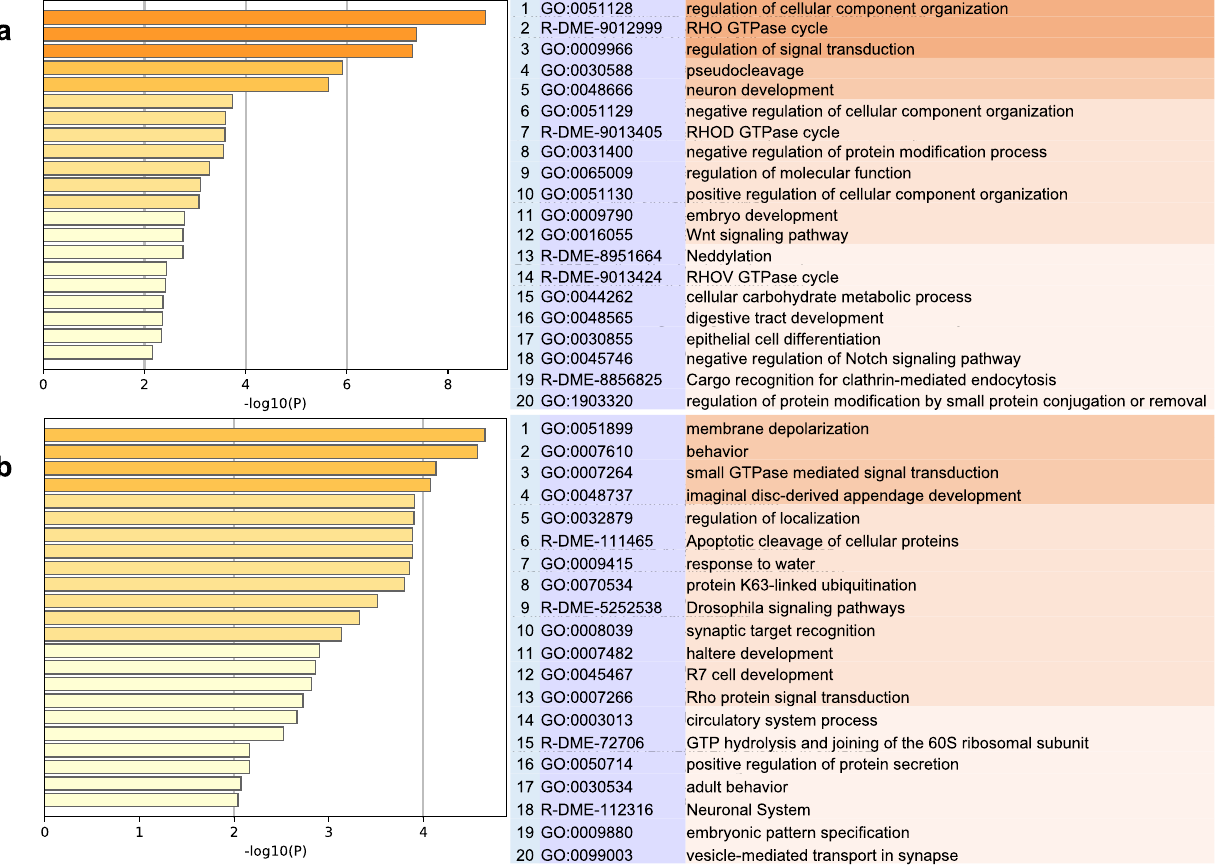
groups generated with Metascape from the upregulated transcripts of the TcSOD6 -knockdown groups included the RHO GTPase cycle (R-DME-9012999) and neuron development (GO:0048666) categories (Fig. 6a). The downregulated transcripts of the TcSOD6 -knockdown groups included the behaviour (GO:0007610), small GTPase-mediated signal transduction (GO:0007264), synaptic target recognition (GO:0008039), adult behav- iour (GO:0030534), and the neuronal system (R-DME-112316) categories (Fig. 6b). Several neuronal development-related genes were included in the differentially expressed transcripts. The top